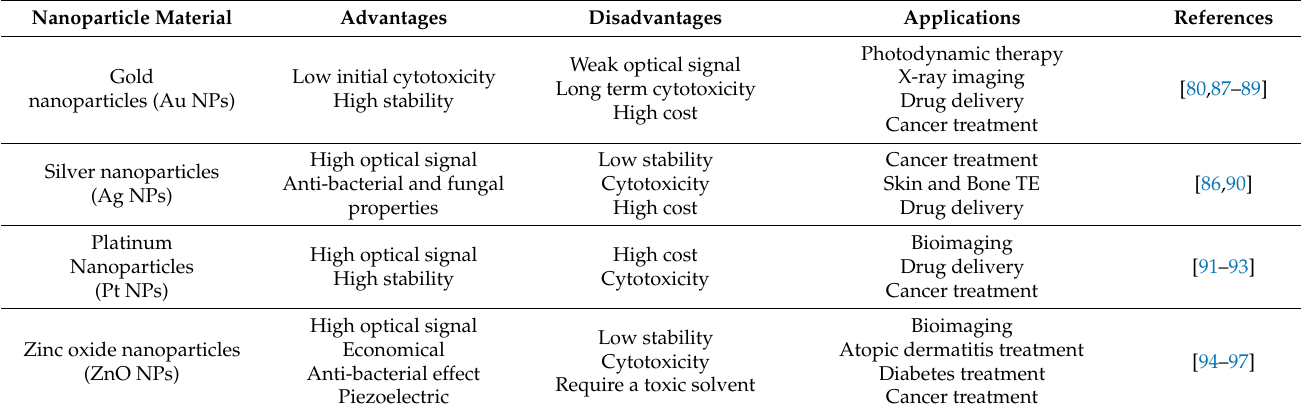
Table 2. Properties and applications of metallic